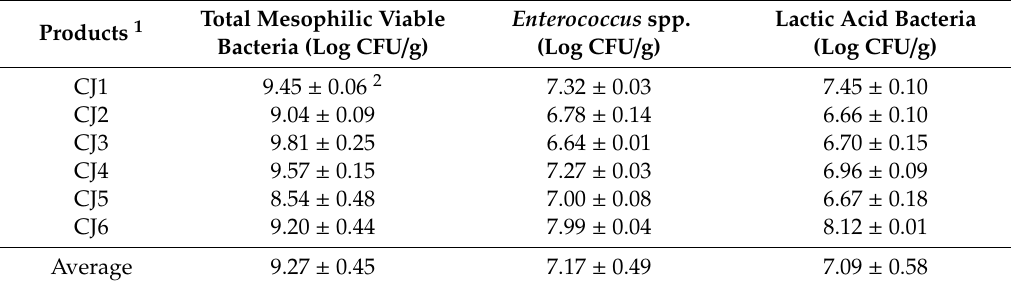
Table 2. Microbial properties of retail Cheonggukjang